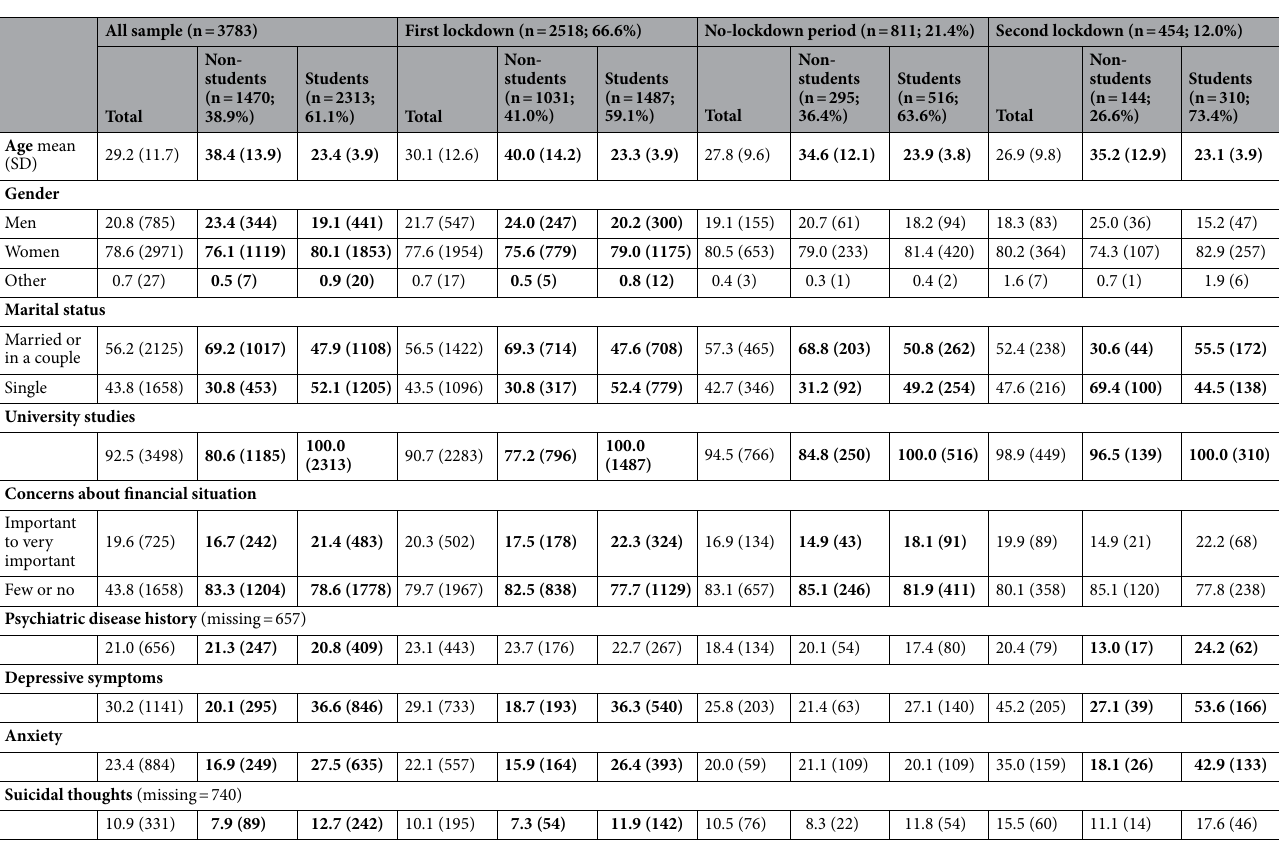
Table 1. Characteristics of the study sample overall and according to the student status and the inclusion period, CONFINS study (2020–2021). All data presented as %( N ) unless otherwise noted (SD: Standard deviation). Two-sided P values < 0.05 were considered statistically significant based on Kruskal–Wallis test for continuous variable and chi-square test for categorical variables comparing students and non-students (results in bold).